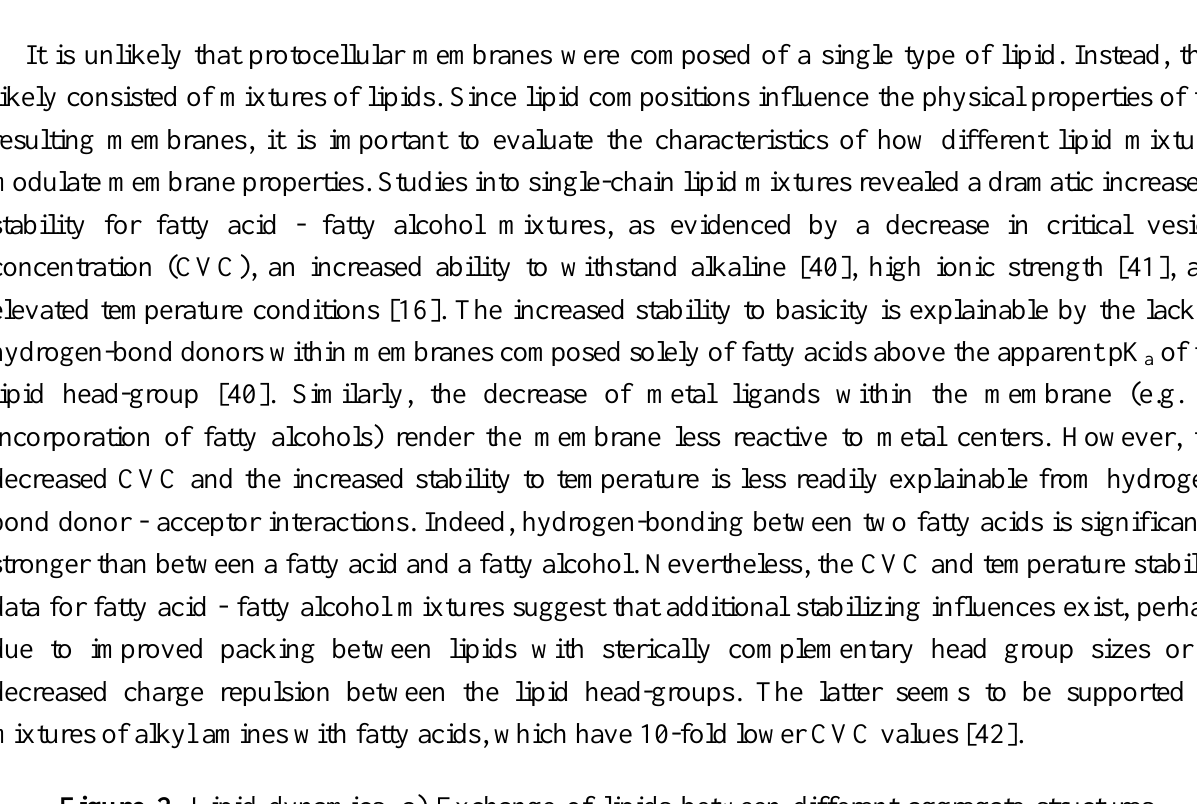
Figure 2. Lipid dynamics. a) Exchange of lipids between different aggregate structures, including micelles (left), free monomers (center), and vesicles (right) b) Lipid flip-flop between inner- and outer-leaflets of a bilayer